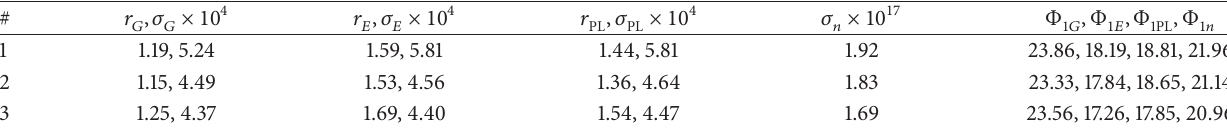
Table 3: Three numerical runs for 1D surfaces emulate the Gaussian correlation of inhomogeneities 𝜂 2 exp (−𝑥 2 /2𝑟 2 ) with 𝑟 = 1.19 and 𝜂 = 0.119 (the assumed [37] roughness of the mirror in earlier GRANIT experiments [2–4, 6]). The true value of the observable Φ 1 for such a surface is Φ 1 = 23.48 . The extracted correlators are fitted with Gaussian, 𝜂 𝐺 exp (−𝑥 2 /2𝑟 𝐺 ) , exponential, 𝜂 𝐸 exp (−𝑥/𝑟 𝐸 ) , and power /[1 + (𝑥/𝑟 ) 2 ] 3/2 fitting functions. The table contains the best fitting values of 𝑟 𝜎 law, 𝜂 𝐺,𝐸, PL , statistical quality of the fits 𝐺,𝐸, PL , and the PL PL . The best fitting values of 𝜂 𝐺,𝐸, are close to each other and are not listed. The columns with Φ 𝑛 and 𝜎 𝑛 give the recalculated values of Φ 1𝐺,𝐸, PL PL values of Φ 1 and the standard deviation when the spectral decomposition of the raw correlation data is put directly into equations for Φ 1 [37] without using the fitting functions.